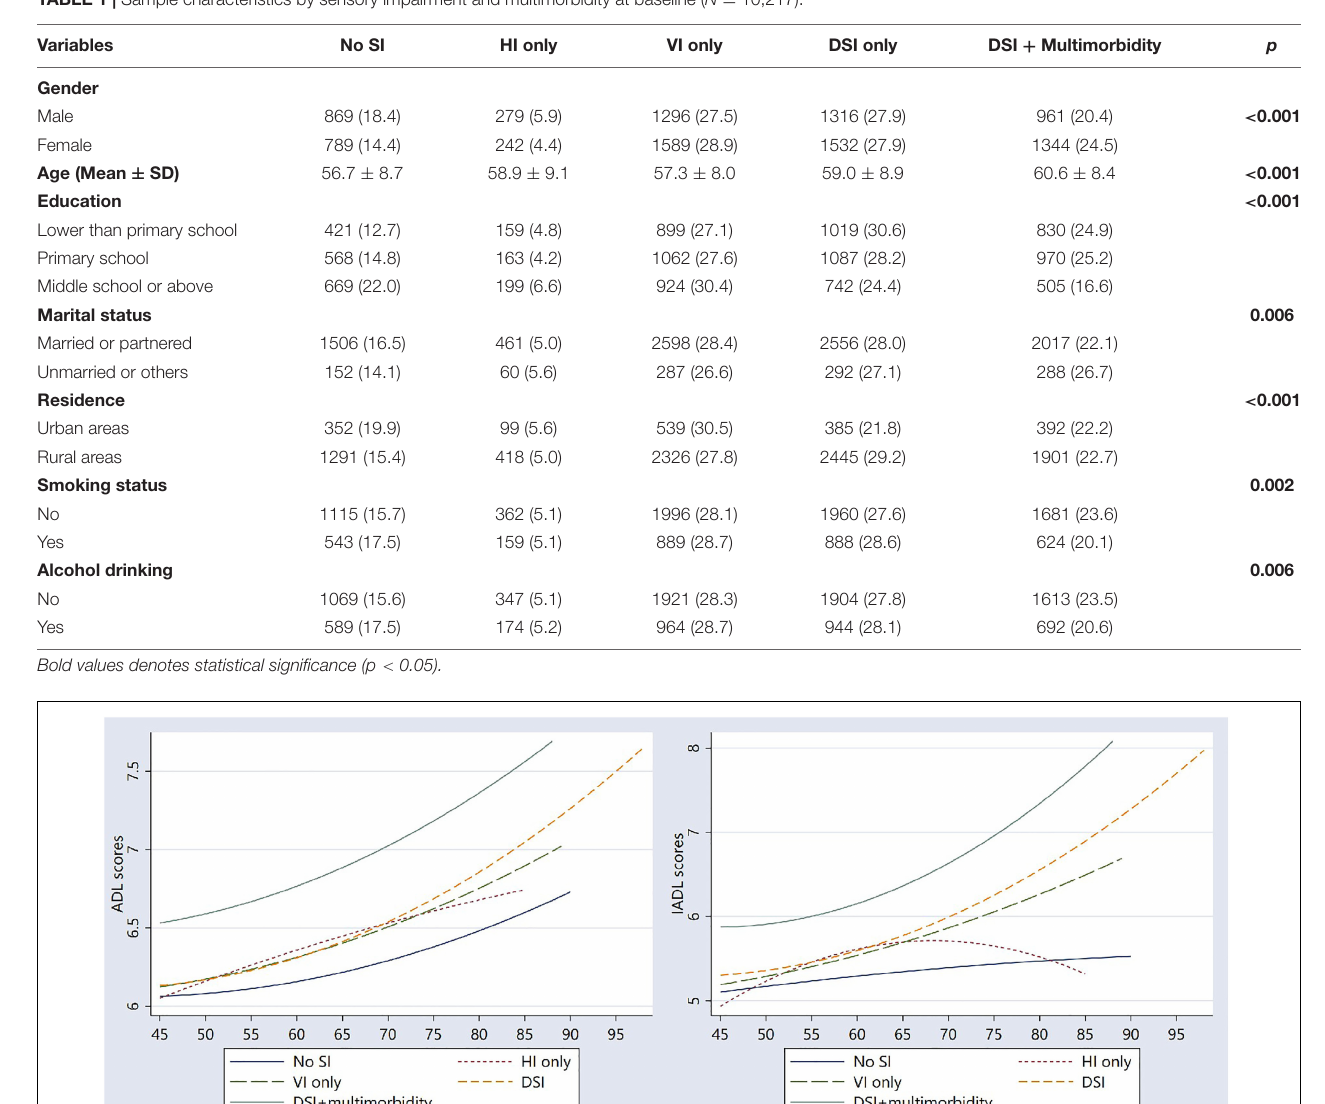
TABLE 1 | Sample characteristics by sensory impairment and multimorbidity at baseline ( N = 10,217).